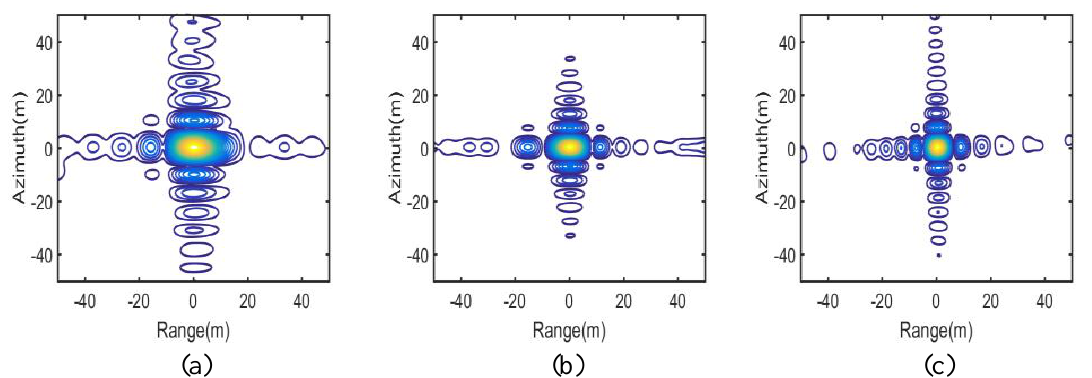
Figure 10. ImPulse Response (IPR) of the targets of the scheme proposed in [18]. ( a ) Target D; ( b ) Target E; and ( c ) Target F.